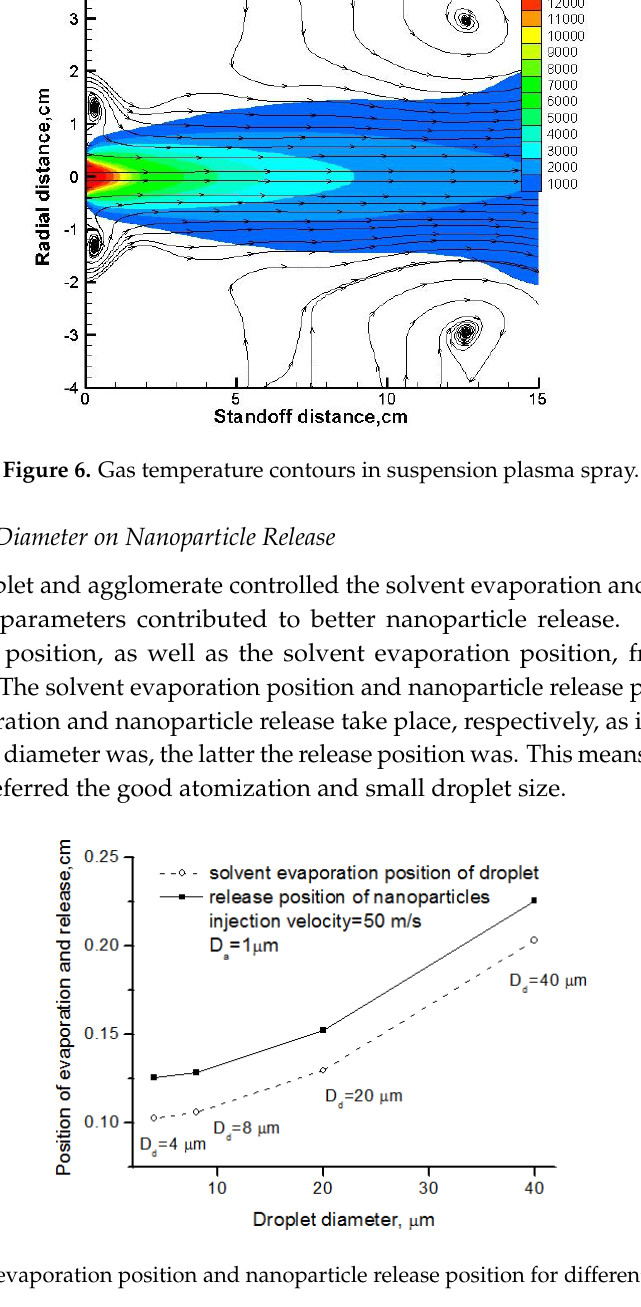
Figure 8. Solvent evaporation position and release position for different agglomerate diameter. 5.3. Effects of Atomization Injection Parameters on Nanoparticle Release The injection angle and injection velocity are key atomization parameters that affect the nanoparticle release. Injection angle, or cone angle, means the angle between the two outer edges of the spray. Zero cone angle indicates that the spray droplets are injected in the centerline. In experiments, cone angle is larger than zero and here we used cone angles of 10 and 20 degrees. We also defined the nanoparticle release percentage as the ratio of the released nanoparticle mass over the total solid mass. As shown in Figure 9, when the injection angle became larger, fewer nanoparticles are released into the flow field. The reason is more particles would be distributed at the fringe of the flow field and could not be well heated up if the injection angle is larger. The particle injection velocity also affected the release percentage of the nanoparticles. Two cases with different initial particle injection velocity of 50 m/s and 500m/s are simulated. Results in Figure 10 showed that, when the injection velocity increasing, the release percentage of nanoparticles became smaller. This is because the high- velocity particles have short flight and heating time in the high-temperature flow field. In addition, the results showed that the nanoparticle release occurred early before the standoff distance of 0.4 cm, since the solvent evaporation point is pretty low at about 350 K while the plasma gas in this region is much higher.